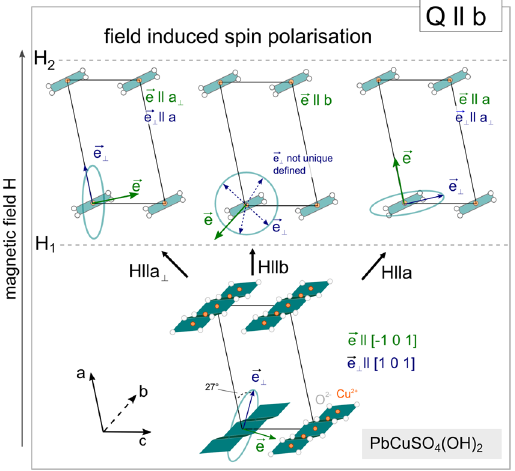
Figure 2. Schematic sketch of the spin configurations in the magnetically ordered phases of PbCuSO 4 (OH) 2 as function of external magnetic field. The switching of the spin spiral for the different magnetic field directions is indicated in analogy to LiCuVO 4 . In the ground state the elliptical helix shows a component in b -direction while the other component is forming an angle of 27° with the a -axis (spiral axis e almost [ − 1 0 1]). H 1 and H 2 indicate phase boundaries between the different magnetic